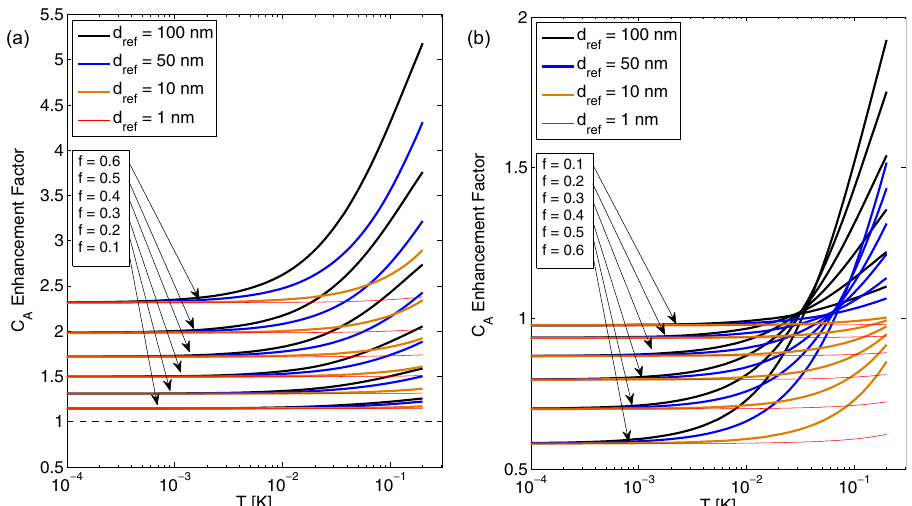
Fig. 8 Heat capacity enhancement factor. The enhancement factor C EMT, A / C full is plotted vs. T for a changing fi lling factor f of SiN PnC metaplate with constant thickness ( a ), and constant area mass density [kg/m 2 ] ( b